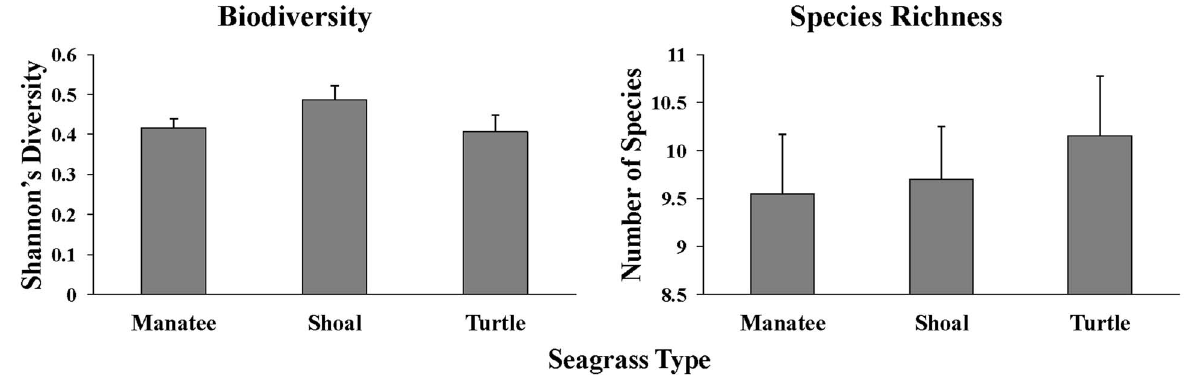
Figure 4. Mean ( + SE) Shannon’s Diversity Index (H 9 ) and species richness among 3 seagrass species.